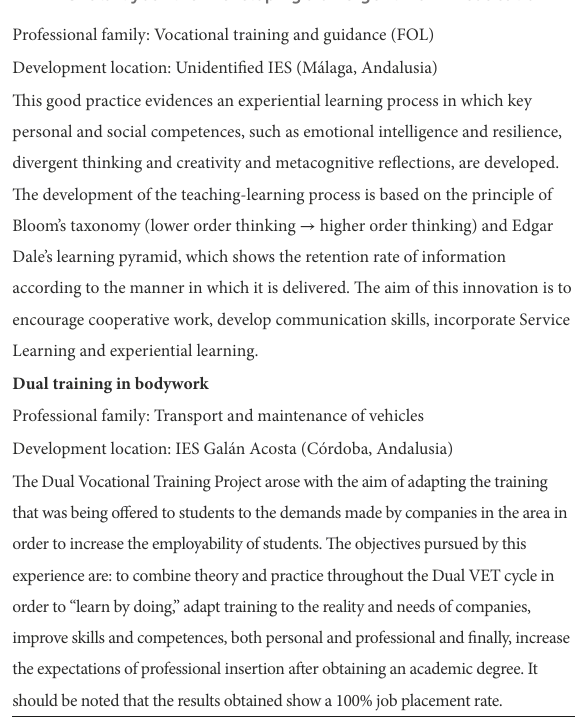
TABLE 8 Virtual immersion in art. TABLE 9 Start your life: Developing a divergent view in